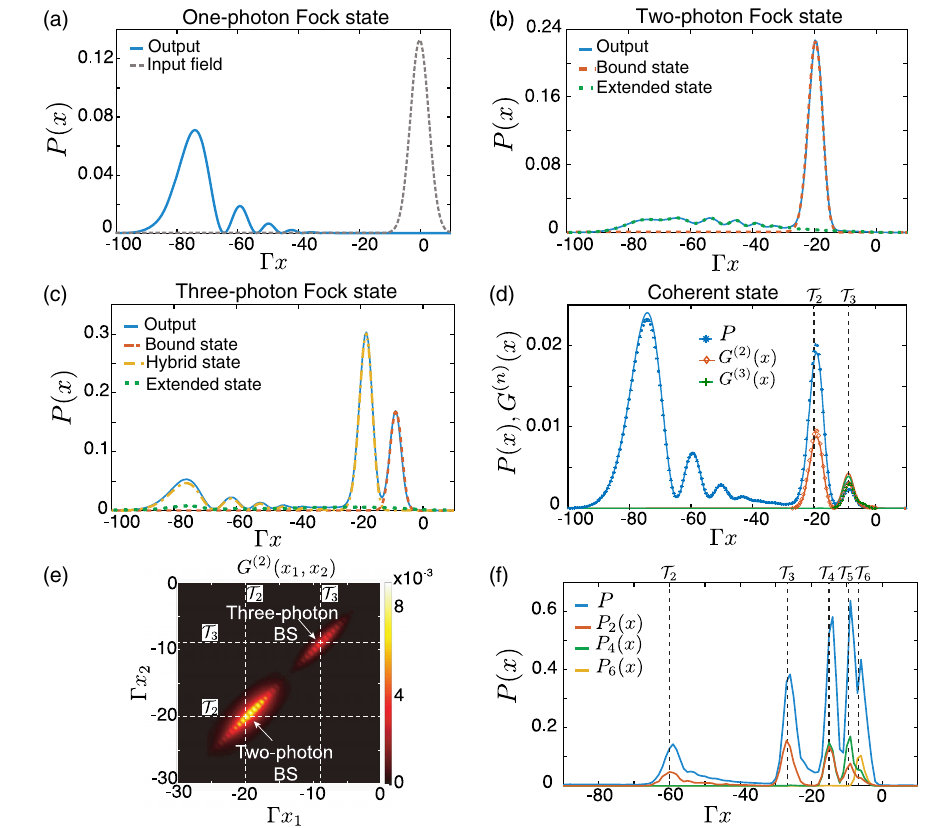
FIG. 2. Transmitted power P ð x Þ (solid curves) for (a) one- (b) two-, and (c) three-photon transport through N ¼ 20 TLSs for a ffiffiffi p 2 resonant pulse with Γ σ ¼ 3 computed using the photon-scattering theory. In (b) and (c), dashed lines show the contributions from the different eigenstates. The input mode in all panels is the Gaussian curve shown in (a). (d) Transmitted power and correlation functions for a coherent state with ¯ n ¼ 0 . 5 . Solid lines show photon-scattering results truncating at three photons, while marker points show MPS calculations performed by solving the ME with a Runge-Kutta algorithm and using maximum bond dimension D order correlation function G ð 2 Þ ð x 1 ; x 2 Þ for the transmitted coherent state computed using photon-scattering theory. The two- and three- photon bound-state contributions appear as peaks that are localized in the relative coordinate. (f) MPS calculation for input coherent state ffiffiffi p 2 with ¯ n ¼ 8 , N ¼ 60 emitters, and Γ σ ¼ 2 . Dashed vertical lines show N times the Wigner delay T P x Þ , we indicate the contribution to the power coming from the emission of n photons within the space bin Δ x ¼ 1 . To perform this n ð calculation, we use a quantum trajectories MPS algorithm fixing the maximum bond dimension to D